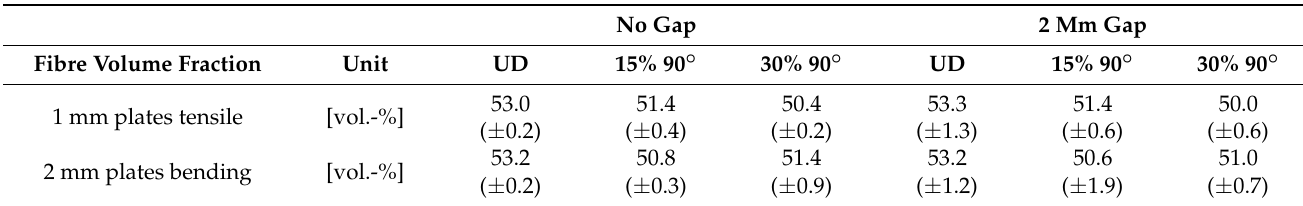
Table 8. Fibre volume fractions for the infiltrated plates used to determine the mechanical properties, standard deviation in () brackets. No Gap 2 Mm